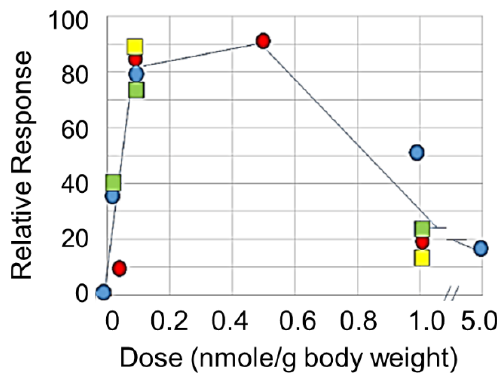
Figure 3. E ff ect of dose on response in C57BL / 6 mice. The peptides were injected subcutaneously and measured endpoints included proliferation of progenitor peritoneal cells in healthy mice (red circles), inhibition of growth of glioma tumors with cells implanted in the brain (blue circles), and survival of mice with implanted ID8 ovarian cancer cells treated with svL4 (green squares) or sv6D (yellow